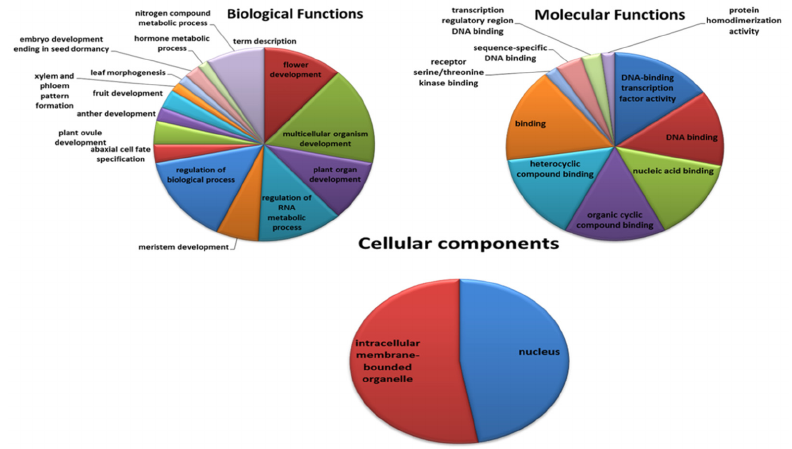
Figure 5. GO enrichment analysis of TaYABBY genes. The data represented as biological processes, cellular processes, and molecular processes.